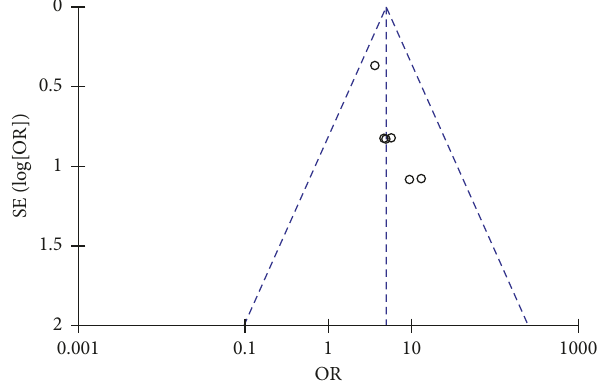
Figure 9: Funnel chart with successful